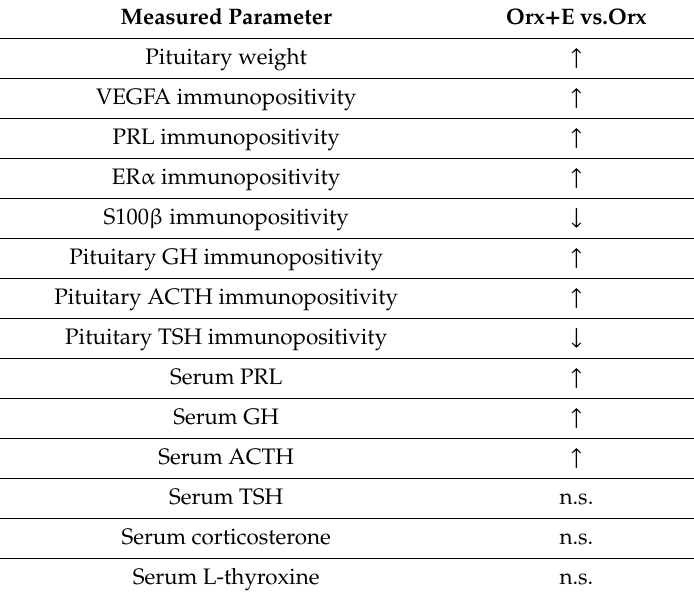
Table 1. The e ff ects of estradiol application on relevant anterior pituitary parameters in orchidectomized middle-aged rats